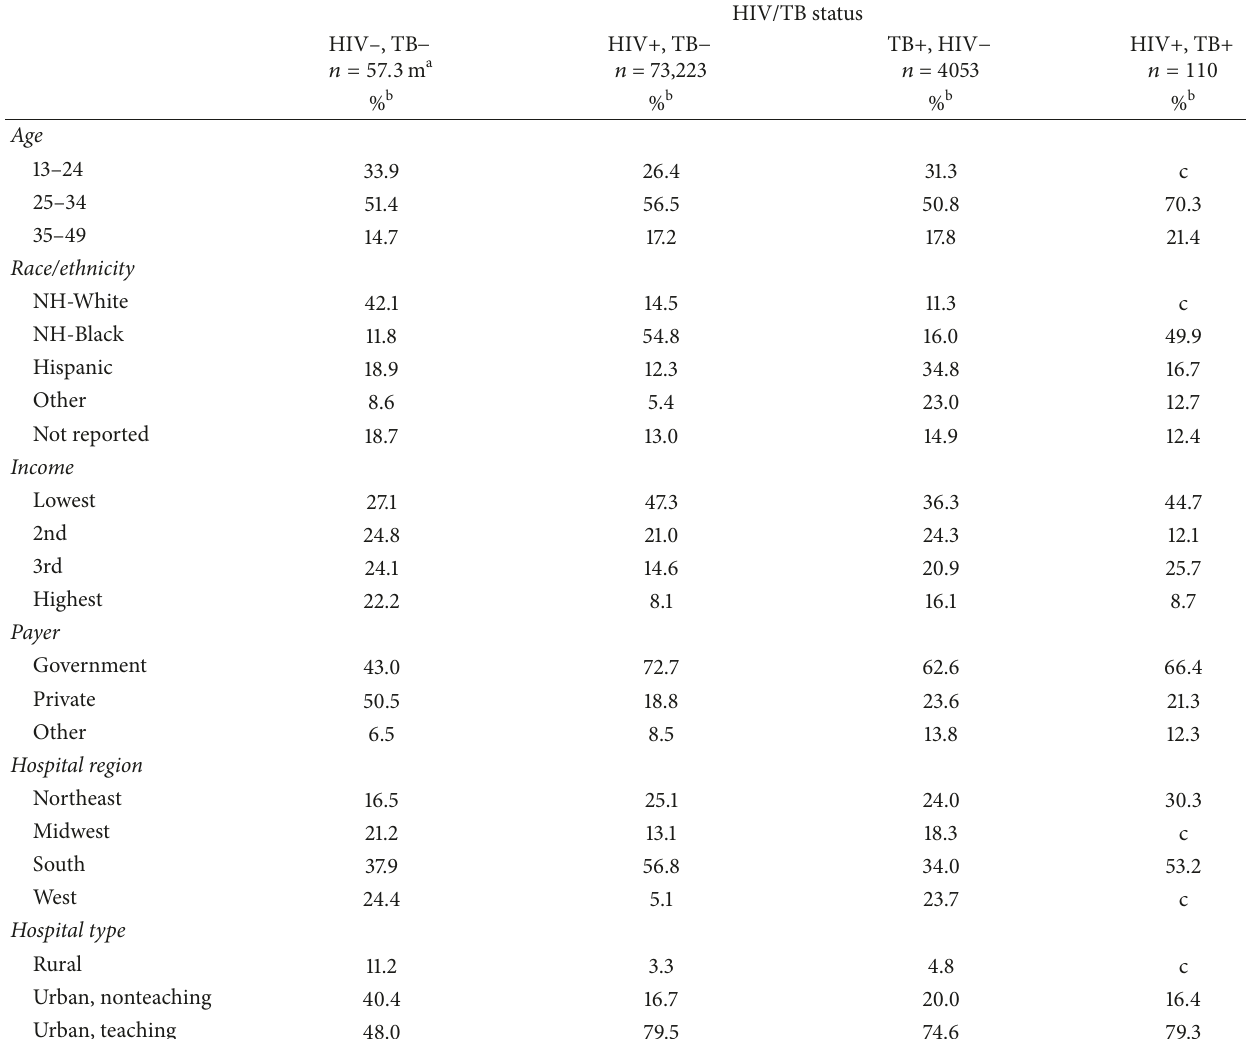
Table 1: Distribution of sociodemographic and health facility characteristics among hospital admissions of pregnant women, by HIV/TB status, United States,